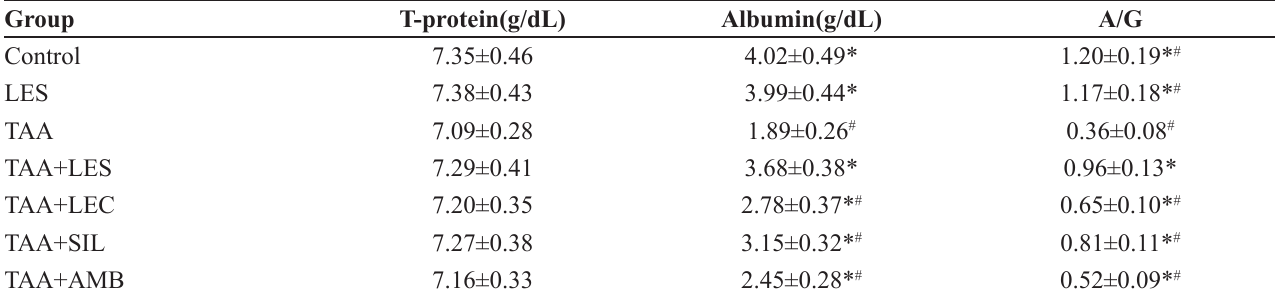
TABLE IV - Effect of TAA, lesimarin and its constituents on total protein, albumin and A/G ratio